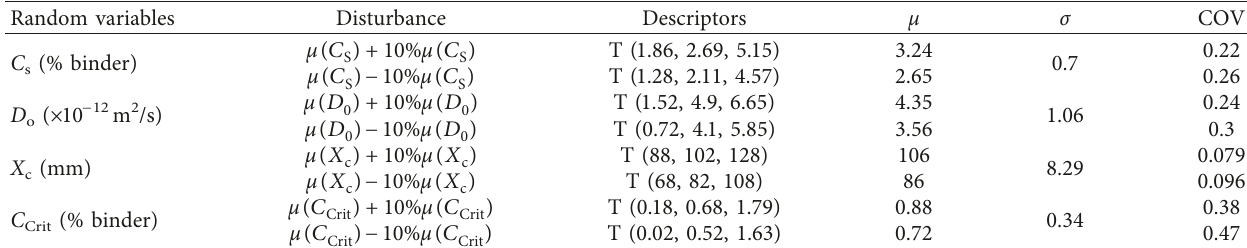
Table 7: Descriptors for sensitivity analysis of the mean of four random